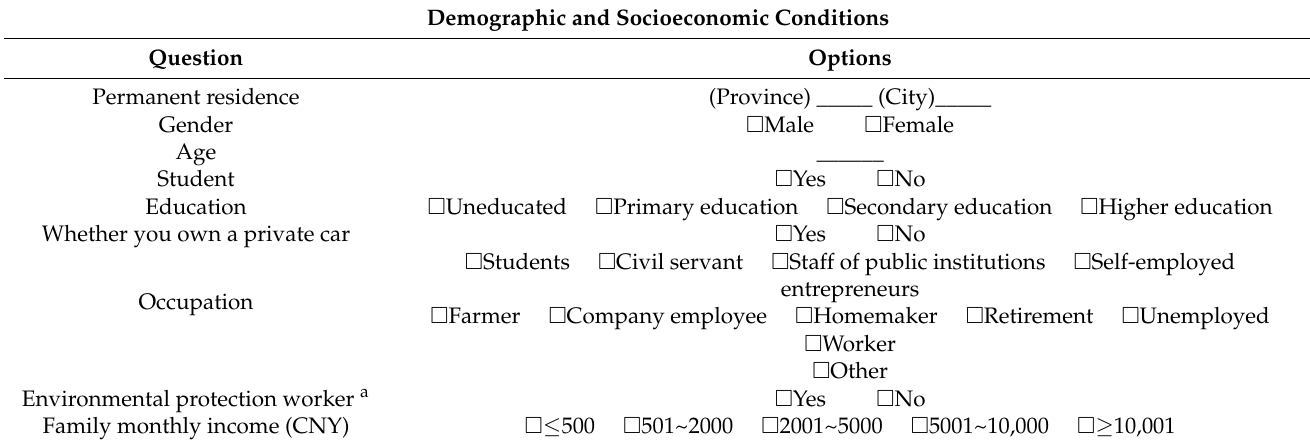
Table A5. The demographic and socioeconomic part of questionnaire A. Demographic and Socioeconomic Conditions